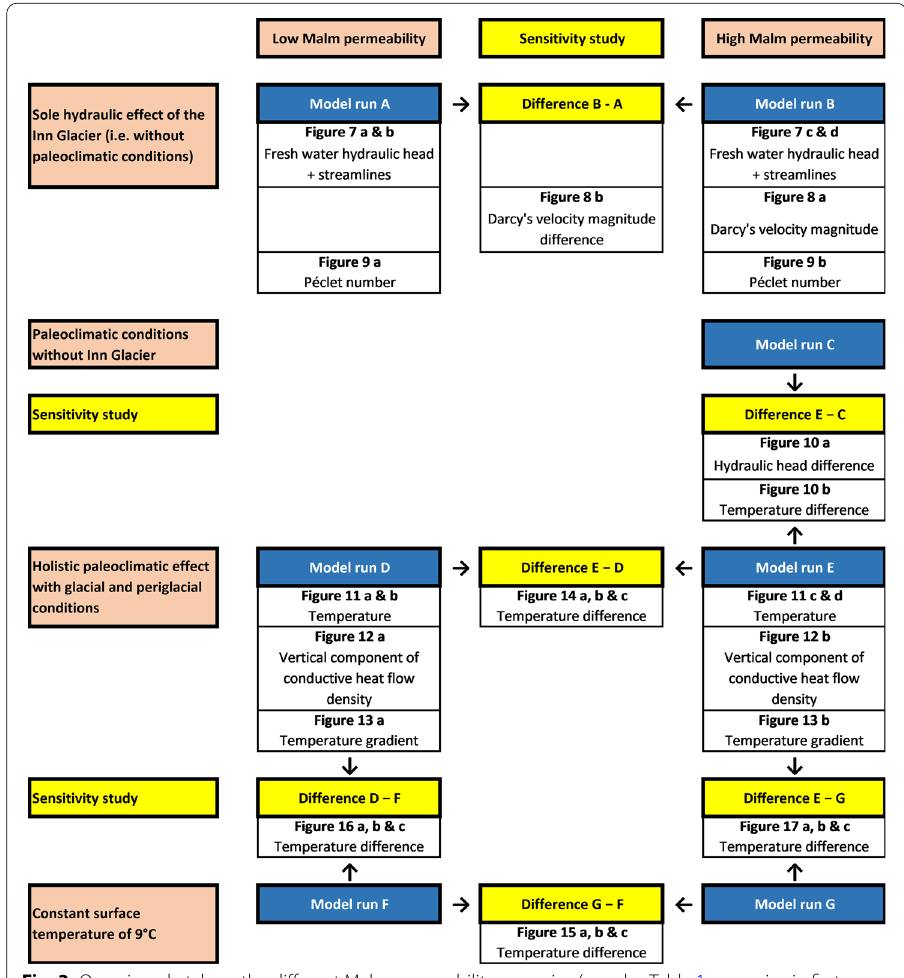
Fig. 3 Overview sketch on the different Malm permeability scenarios (see also Table 1; scenarios in first row refer to model runs in the corresponding second and fourth columns) and surface temperature